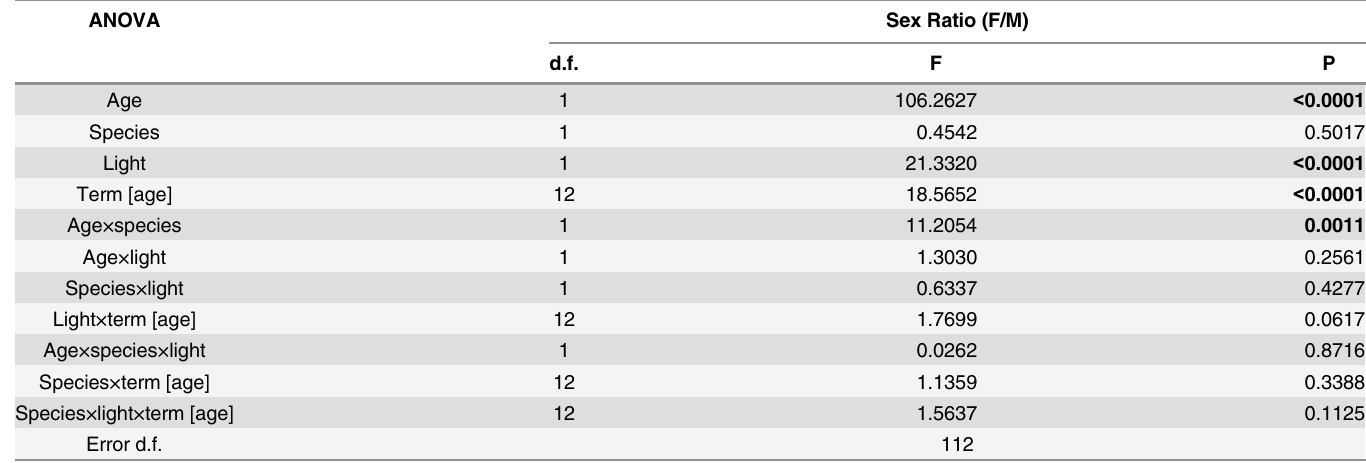
Table 2. Summary of ANOVA on the effects of time of occurrence (age: current-year vs 1-year-old), cherry species ( Prunus padus vs P . serotina ), light conditions (high light vs shade), term (length of the sampling period, see Materials and Methods) and their interactions on the F/M sex ratio of adult Gonioctena quinquepunctata beetles. The factor “ term ” was nested in the factor “ age ” (term[age]). P values < 0.05 are in